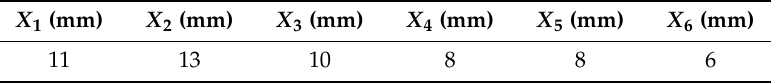
Table 2. Distance between CSRRs as shown in Figure 1b.